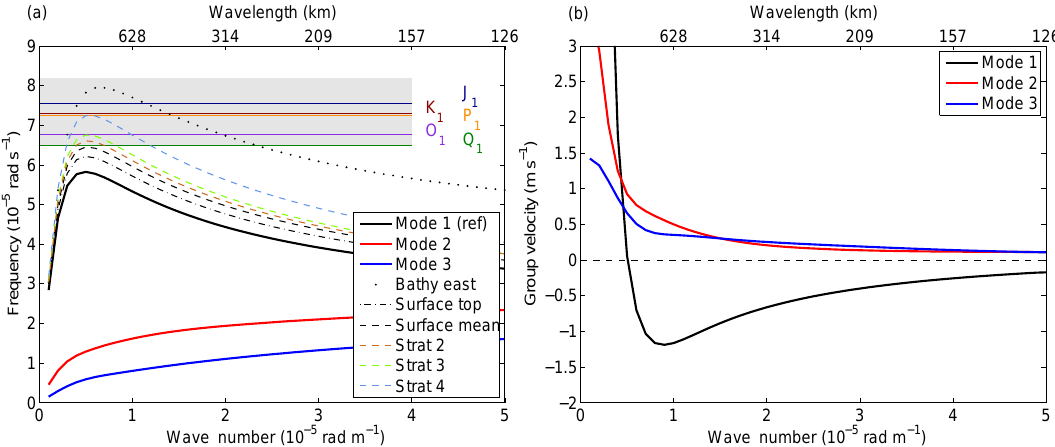
Figure 9. (a) Dispersion curves for CTWs of modes 1–3 using the reference stratification (thick lines). In addition, the dispersion curves for mode 1 CTWs for the bathymetry east of the study area (“bathy east”), differently inferred surface N 2 values for the reference stratification (“surface top”, using the uppermost value of the observational stratification profile, and “surface mean”, using the average of the upper 80m of the observed stratification profile) and three other stratification profiles are shown. Stratification profiles 2–4 are representative of regions in the study area with increasing distance west of the reference stratification and inferred similarly. The diurnal tidal band is shaded in light grey with the most important diurnal frequencies marked by coloured lines. (b) Group velocities for CTWs of modes 1–3 using the reference stratification. Zero group velocity is indicated by a dashed line.